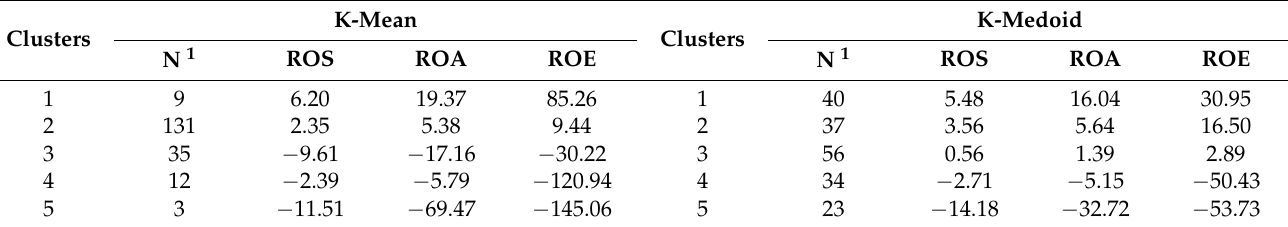
Table 6. Average financial indicator values per cluster (%) for Hungarian companies.